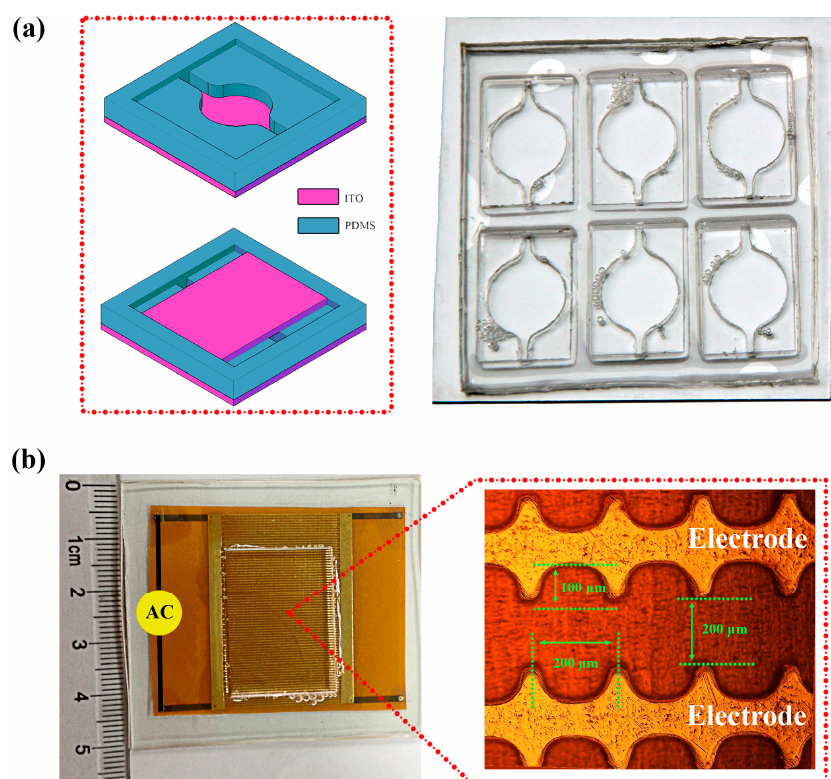
Figure 1. Illustration of the 3D and 2D experimental setup. ( a ) The 3D electrode system consists of a top and a bottom indium tin oxide (ITO) electrode separated by a polydimethylsiloxane (PDMS) spacer. The chip used in experiments contains six subcells and allows several groups of experiments to be carried out at the same time. ( b ) The 2D electrode system with many microelectrode arrays.